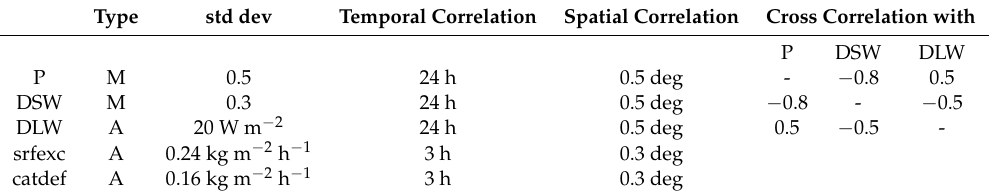
Table 2. Ensemble perturbations applied to the forcing variables—precipitation (P), downward shortwave (DSW) radiation, and downward long wave (DLW) radiation—and to the Catchment model prognostic variables—surface excess (srfexc) and catchment deficit (catdef). Shown are the perturbation types, which are either multiplicative (M) sampled from a log-normal distribution or additive (A) sampled from a normal distribution, as well as the perturbation standard deviation (std dev), the temporal and spatial correlation lengths, and the cross-correlations of the forcing variables. Perturbations to the prognostic variables are not